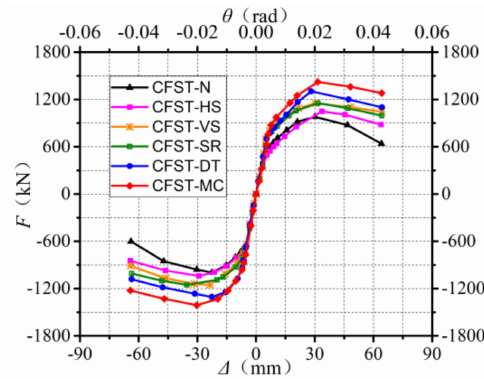
Figure 8. Skeleton curves of specimens.